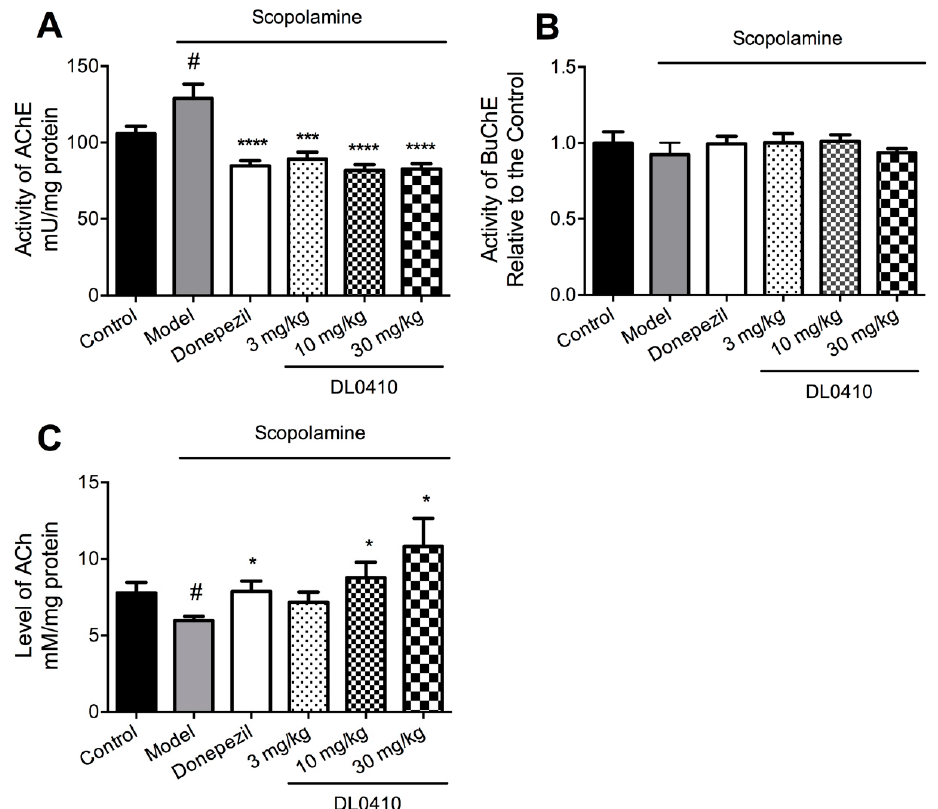
Figure 7. The effect of DL0410 on the activity of acetylcholinesterase (AChE) and BuChE and acetylcholine (ACh) levels in the hippocampus. Data are expressed as mean ± SEM ( n = 6). ( A ) The activity of AChE in the hippocampus; ( B ) The activity of BuChE in the hippocampus; ( C ) The ACh level in the hippocampus. # p < 0.05 vs. the control group; * p < 0.05, *** p < 0.001 and **** p < 0.0001 vs. the model group.